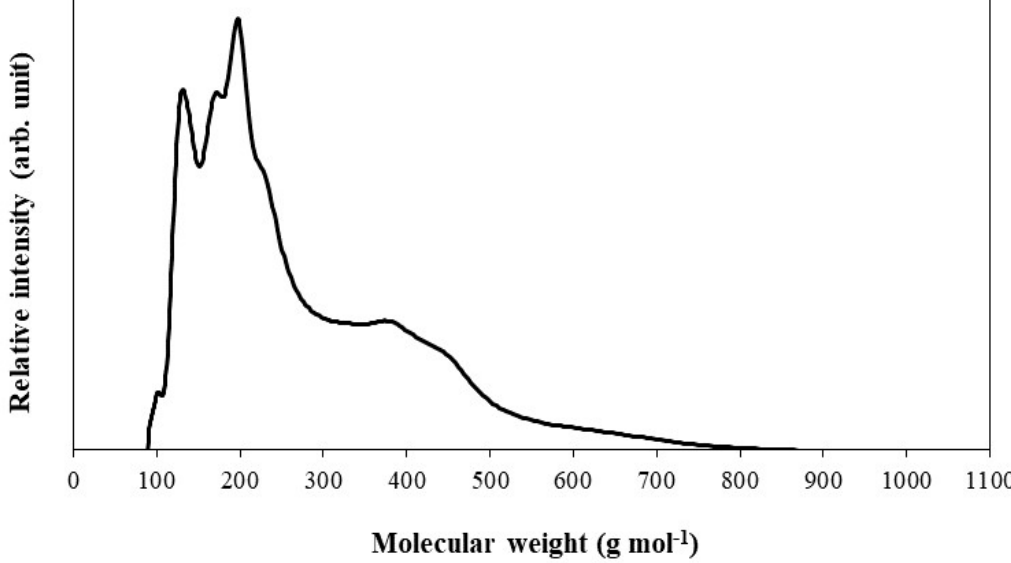
Figure 6. GPC chromatogram of bio-oil obtained from pigeon pea wood pyrolysis at optimized conditions.